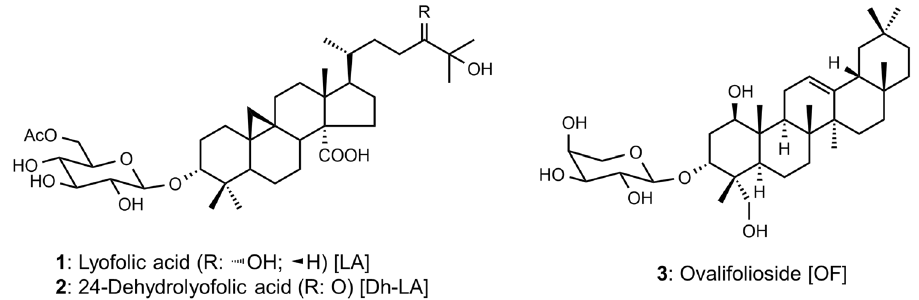
Figure 4. Structures of triterpenoid glycosides ( 1 – 3 ) isolated from leaves of Lyonia ovalifolia